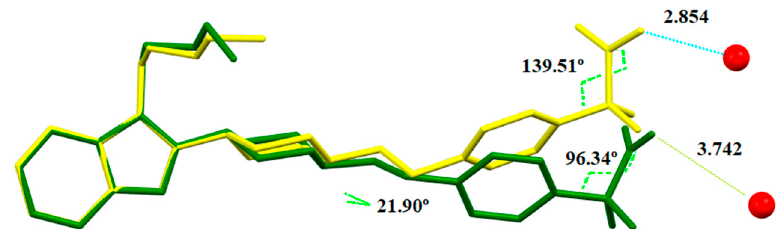
Figure 22. Overlay of BL molecules of form S 3CHCl3-H2O (yellow) and S CHCl3-H2O (green) showing that the water molecule (represented by red balls) is too far (distances in Å) from the carboxylate of S CHCl3-H2O . Hydrogen atoms are omitted for clarity.